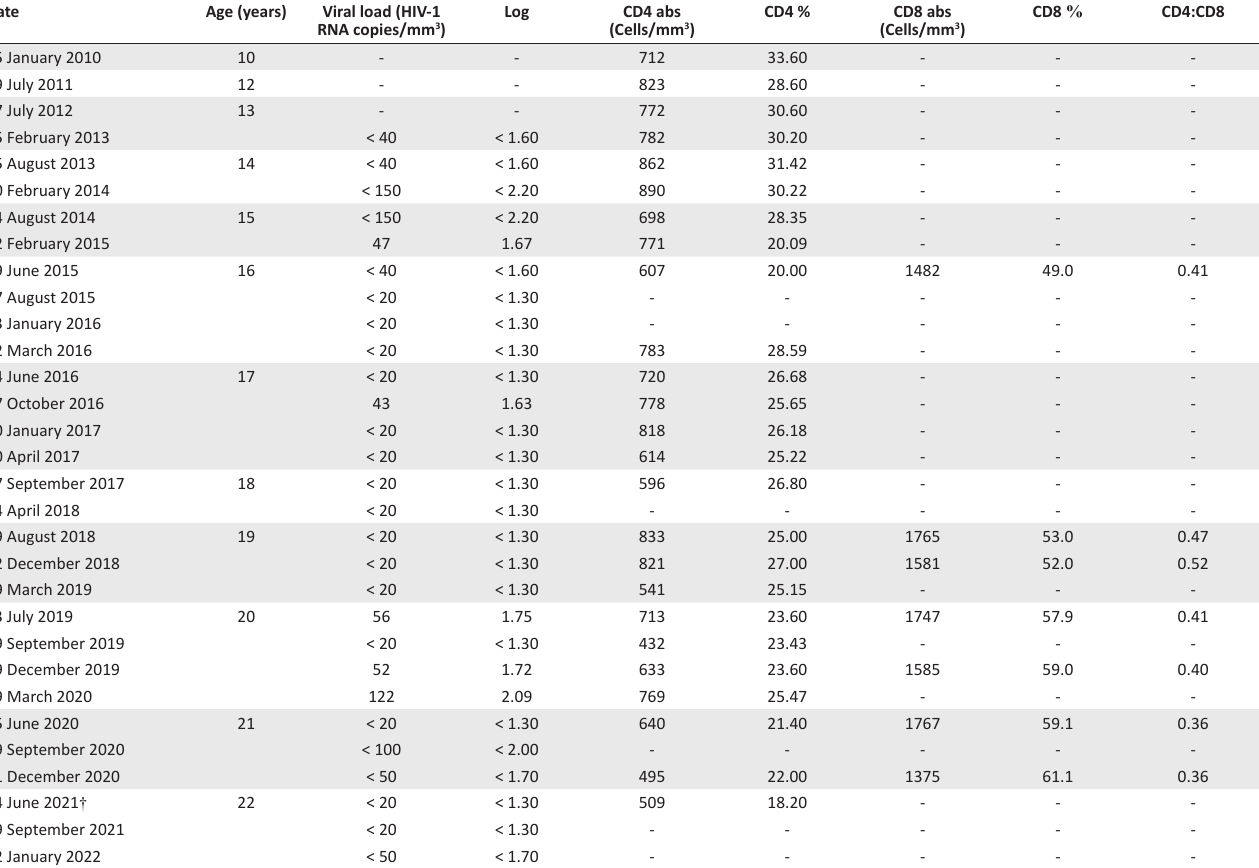
TABLE 4a: Laboratory data for patient